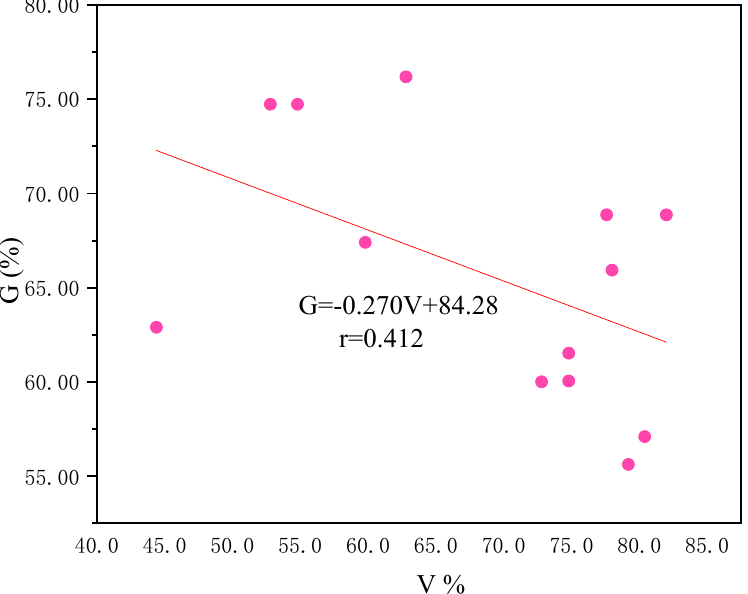
Figure 2. Scatter diagram of coal-based graphitization degree (G%) and vitrinite proportion (V%).